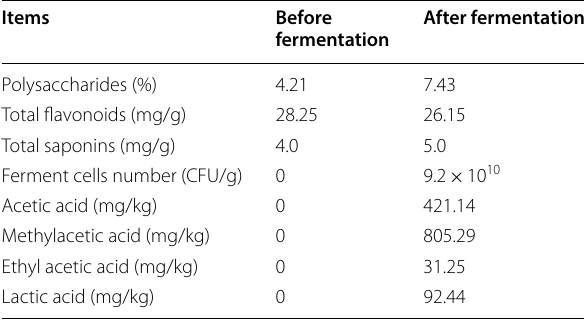
Table 2 Composition of the basic diet (as a percentage of dried weight)